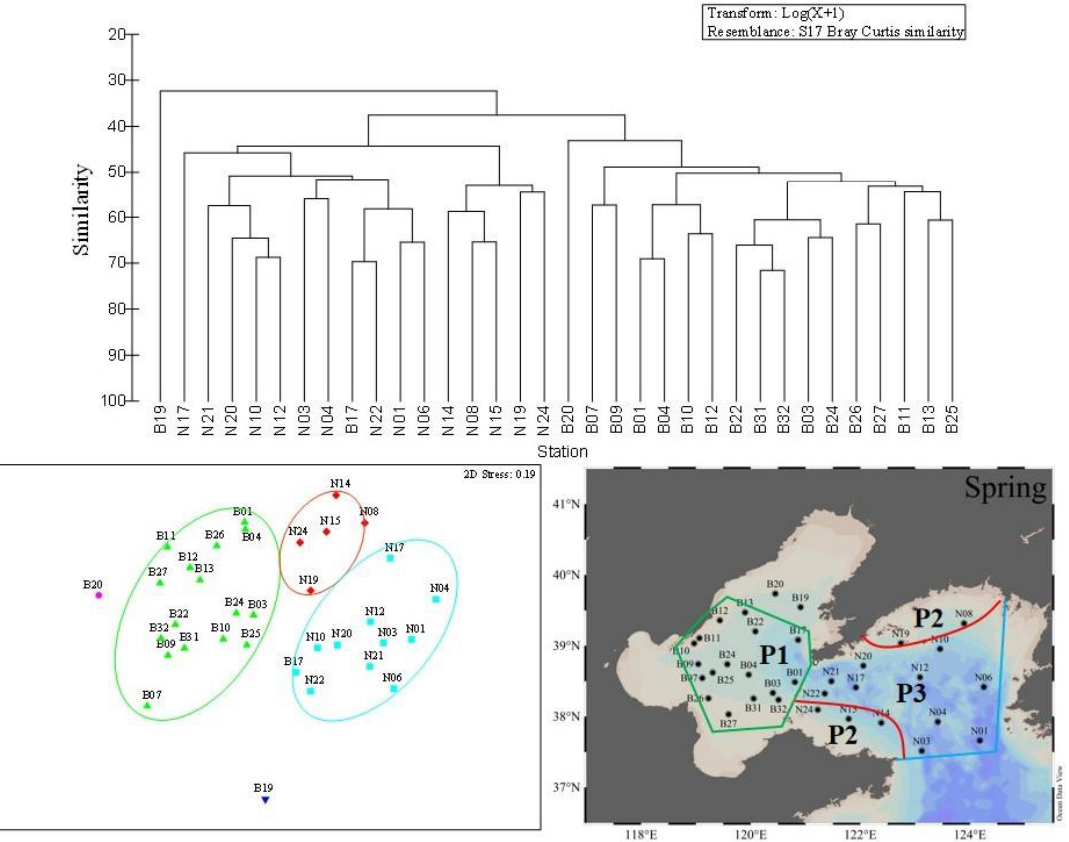
Figure 5. Cluster analysis (left) and MDS (right) of the top 15 dominant species at each sampling station in spring. Each symbol represents a sampling station: green triangles = first assemblage, blue squares = second assemblage; red diamonds = third assemblage.